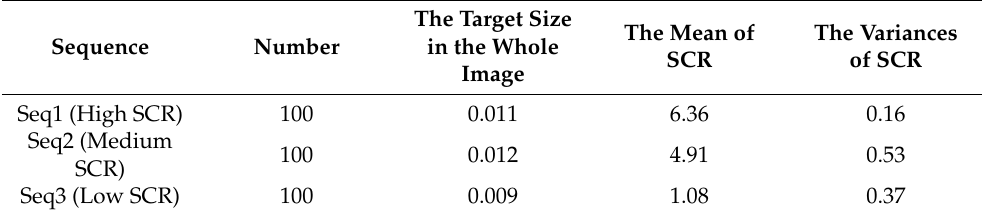
Table 2. Details of the three